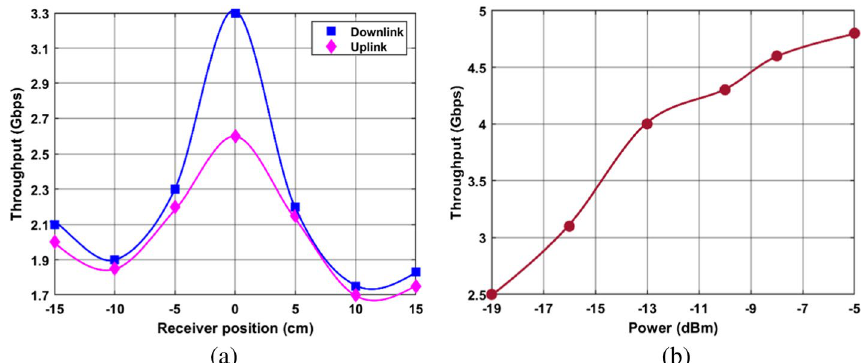
Fig. 19 Link performance of DMT incl. 1.2 m VLC transmission for the downlink and uplink ( a ) and POF throughput without wireless for various optical power ( b